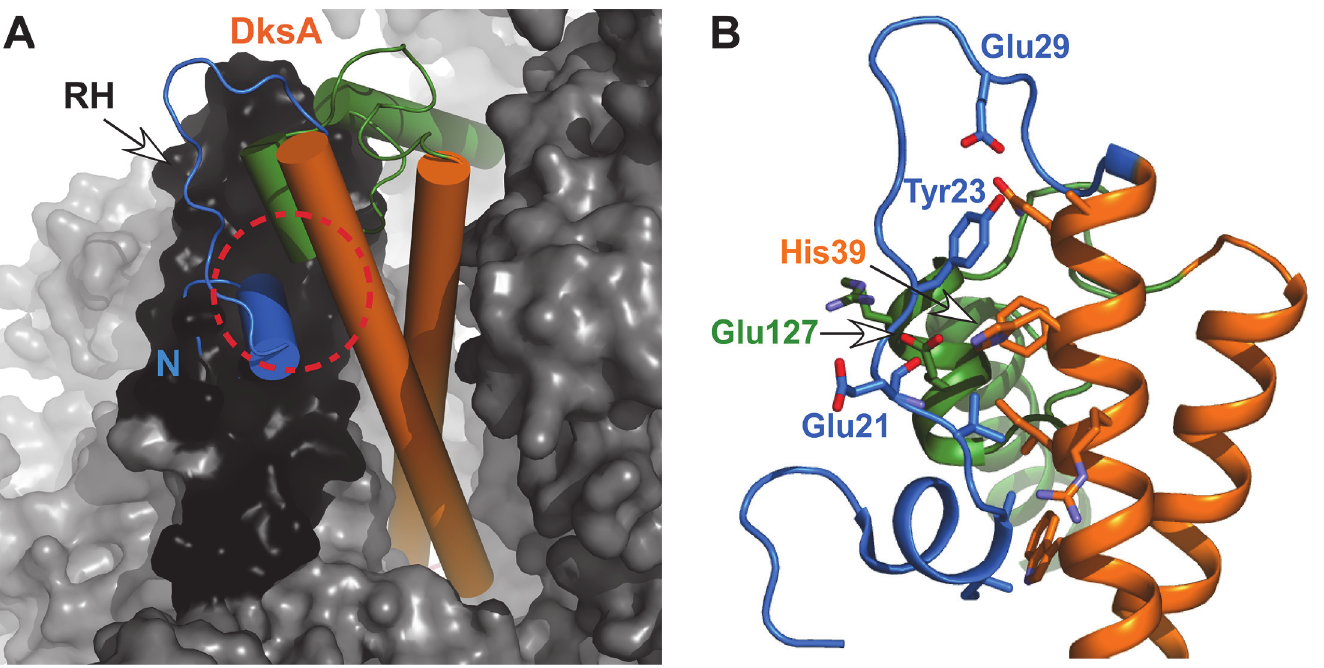
Fig 2. Conformational changes may be required to accommodate DksA in the secondary channel. (A) Hybrid model of DksA (PDB id: 1TJL_a) docked in the secondary channel of the E . coli RNAP core (PDB id: 3LU0). Clash between N-terminus and rim helix (RH) implies required conformational change and remodeling of domain interface (circle). (B) DksA structure reveals a large interface between the globular domain of the protein and parts of the CC domain. Residues that can contribute to the interdomain interactions are indicated. The CC domain is shown in orange, the N-terminal region in blue, and the C- terminal region in